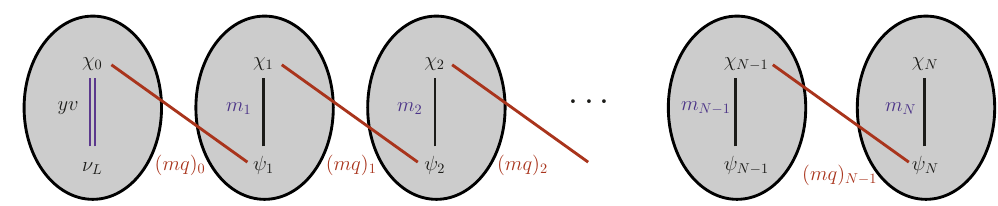
Figure 1 . Pictorial representation of the clockwork sector with right-handed zero mode. Single solid lines denote Dirac masses, while the double solid line denotes the Yukawa couplings